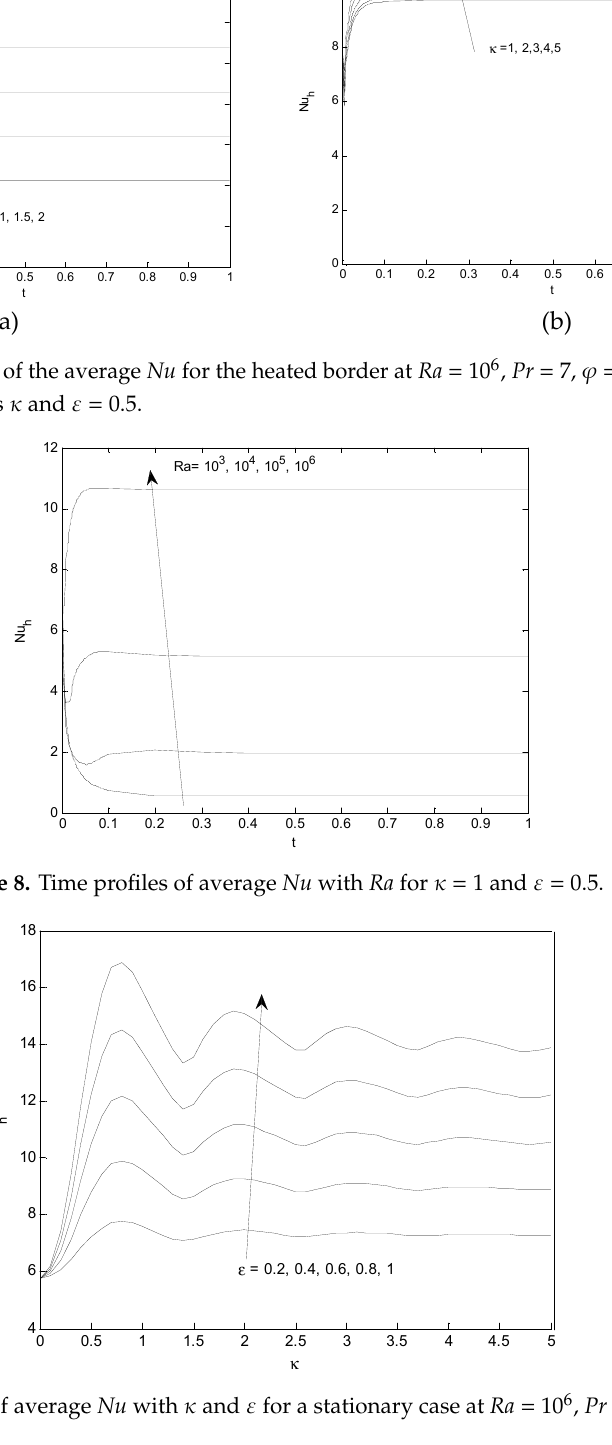
Figure 9. Profiles of average Nu with κ and ε for a stationary case at Ra = 10 6 , Pr = 7, ϕ = π /3.